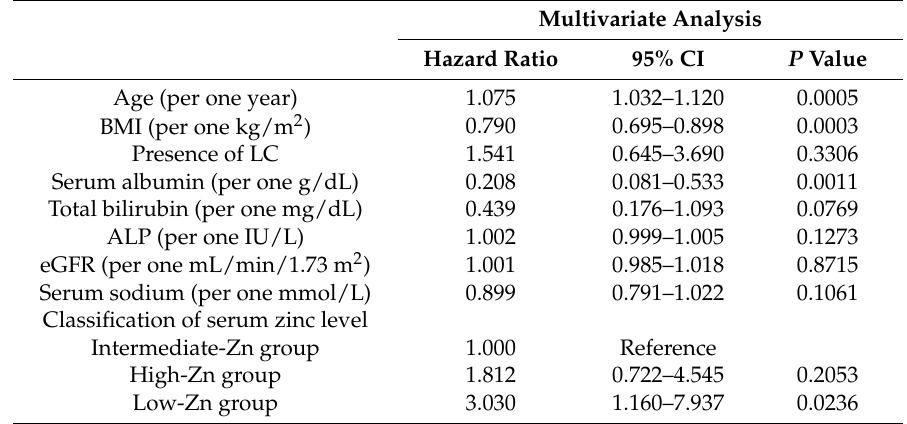
Table 3. Multivariate analyses of factors linked to the presence of sarcopenia for all cases. Multivariate